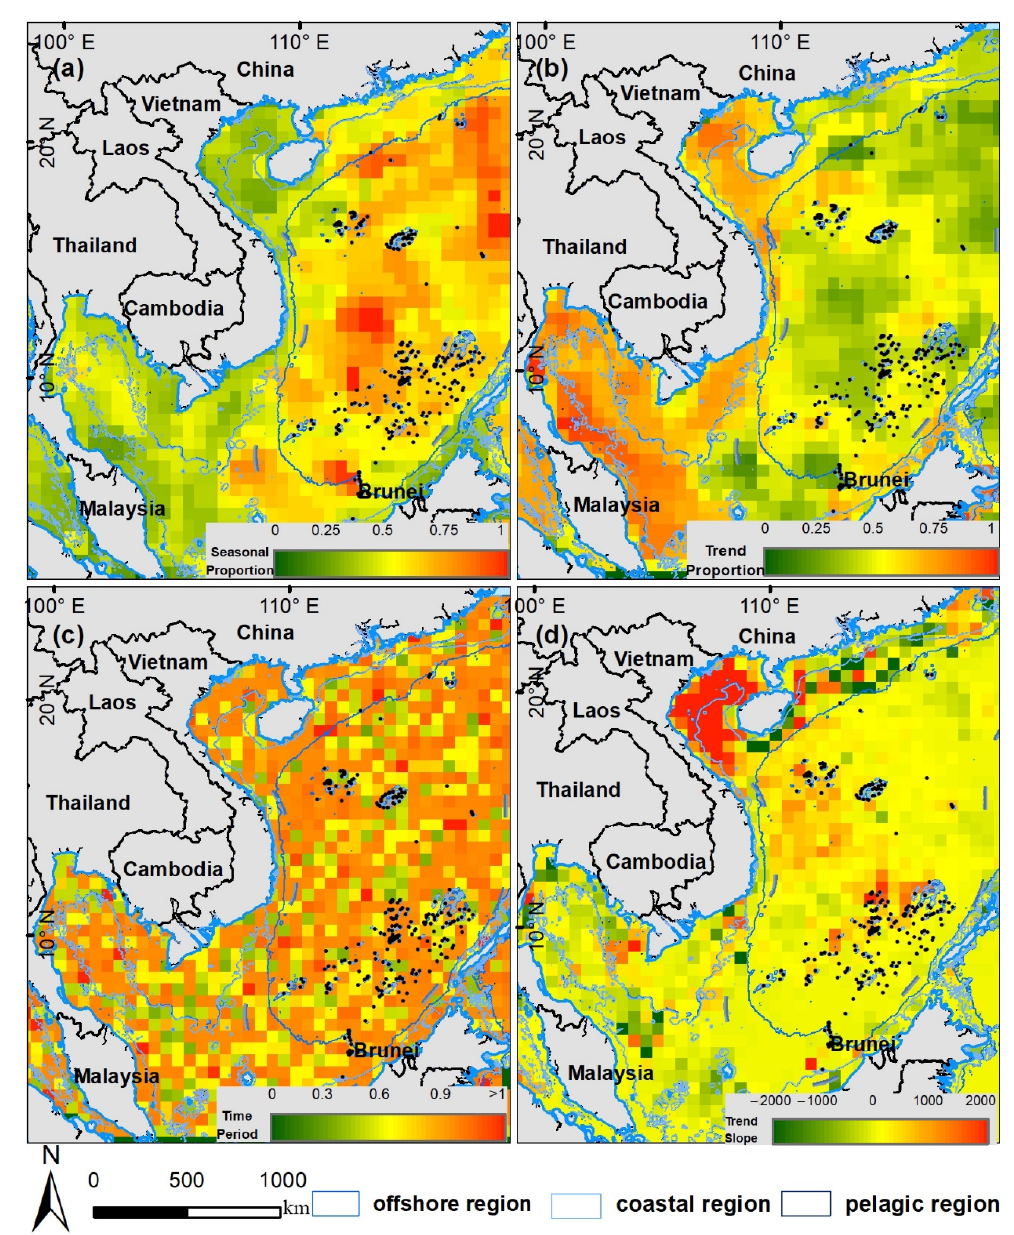
Figure 9. HHT-obtained results in the SCS: ( a ) seasonal proportion, ( b ) trend proportion, ( c ) time period, ( d ) trend slope. Time period is a key element for describing intra-annual periodic fluctuations that have a regular cycle driven by diverse drivers such as annual climate conditions, seasonal regulations and socio-economic status. Figure 9c indicated that time cycles in the SCS varied spatially, and time cycle for most grids (90.8%) fell into the range of 0.6–1.1 years with a few exceptions in southern China, pelagic regions and Gulf of Thailand. The results indicated a significant seasonality of fishing activity with an overall time cycle of 0.79 years across the